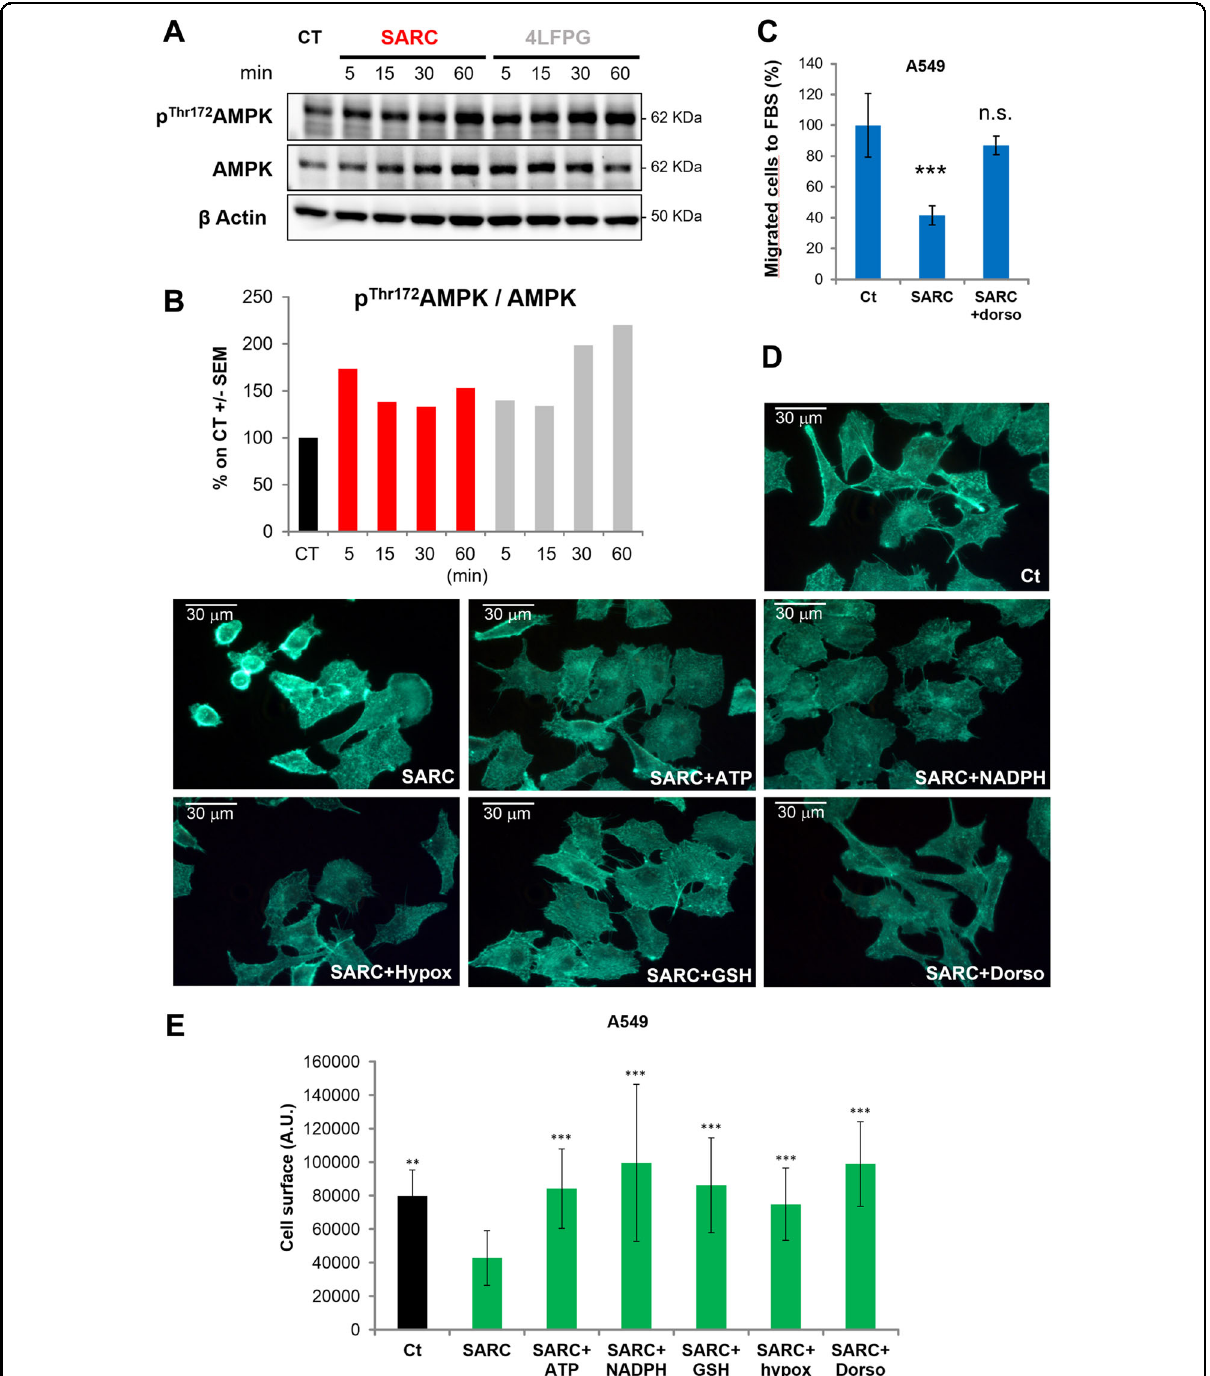
Fig. 6 AMP kinase is the sensor of serine starvation modulating cell migration. A Western blot images showing a time course of p-AMPK Thr172 and total AMPK protein levels in presence of 100 μ M SARC or 4LFPG; actin was used as loading control. B Densitometric evaluation of the p-AMPK Thr172 / AMPK ratio. Data are expressed as percentage of CT set as 100%, the experiment has been repeated three times with similar results. C Migratory ability of A549 cells to serum in the presence of sarcosine and dorsomorphin. Cells pretreated for 3 h with 25 μ M SARC ± 2 μ M dorsomorphin (dorso) and non- pretreated control cells were tested in Boyden chamber assay (Ct) ( n = 3). D F-actin visualization using phalloidin in A549 cells, after incubation for 24 h with each of the indicated compounds (25 μ M SARC plus 25 μ M ATP or hypoxanthine (hypox), 200 μ M GSH, 150 μ M NADPH, or 0.5 μ M dorso). E Cell surface analysis of three images taken at the end of the experiment shown in ( D ); average ± SD is shown. ** P < 0.01; *** P <